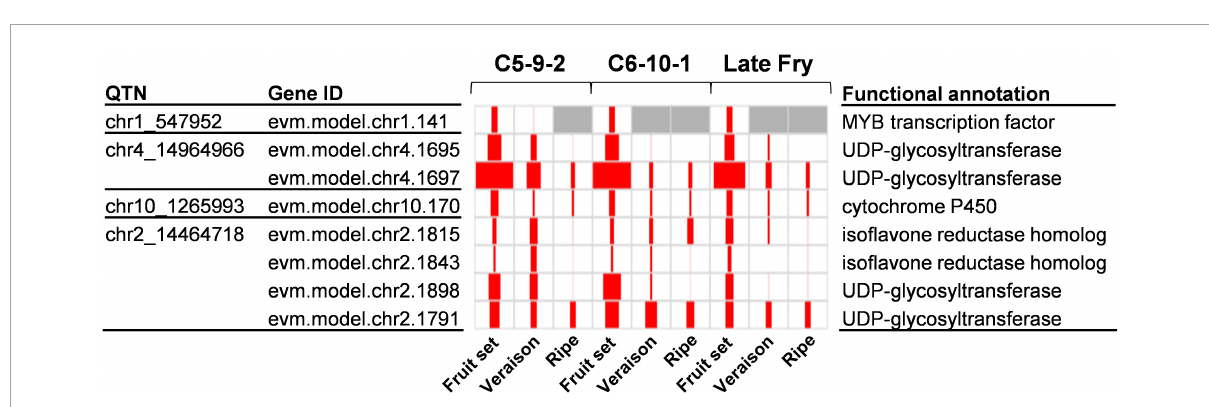
FIGURE4 Expression of candidate genes identified by chr2_14464718. The QTN name and corresponding gene ID are listed on the left side of the panel. The functional annotation information is listed on the right side of the panel. In the panel, the size of red squares represents the TPM value of the corresponding gene. The max TPM was